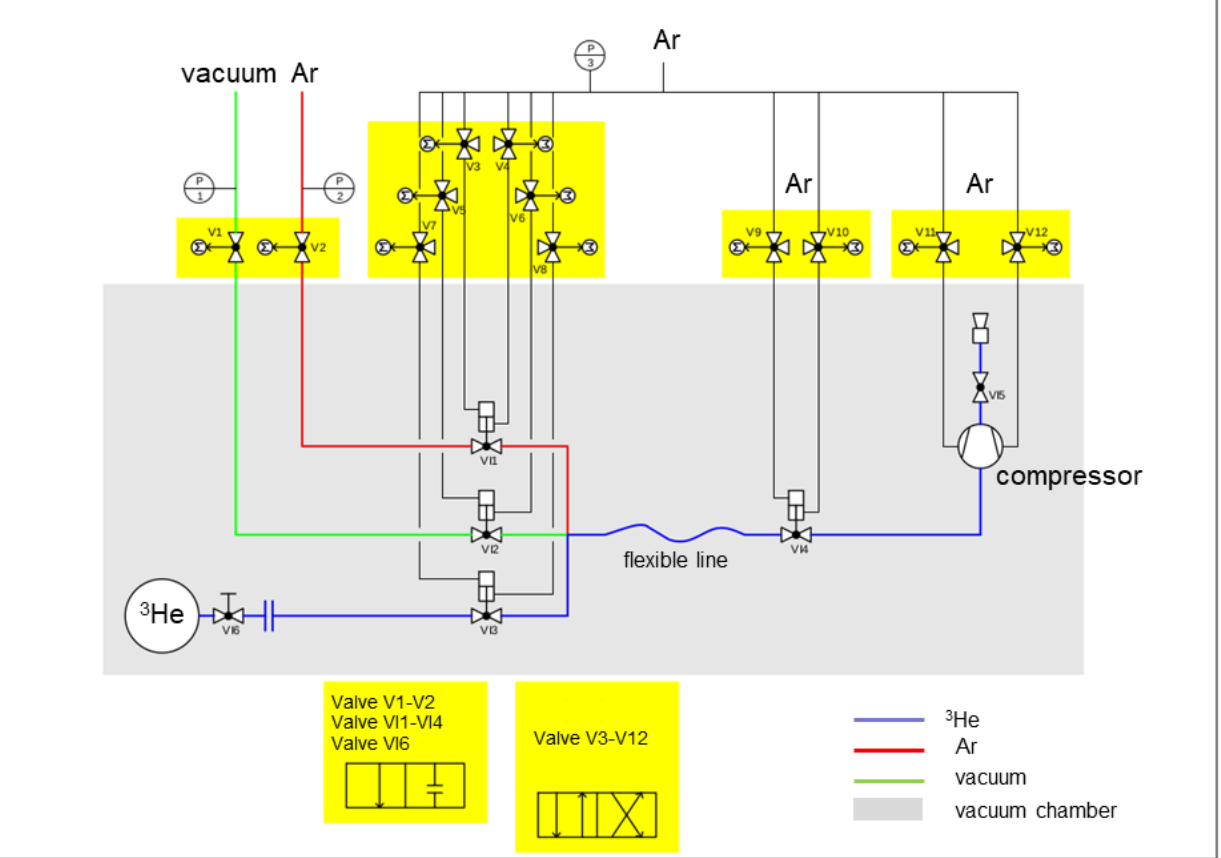
Figure 18. Schematic view of the gas system. The components that are located in the magnet system and inside the vacuum chamber are indicated by the gray rectangle. The 3 He, Ar and vacuum lines are represented by different